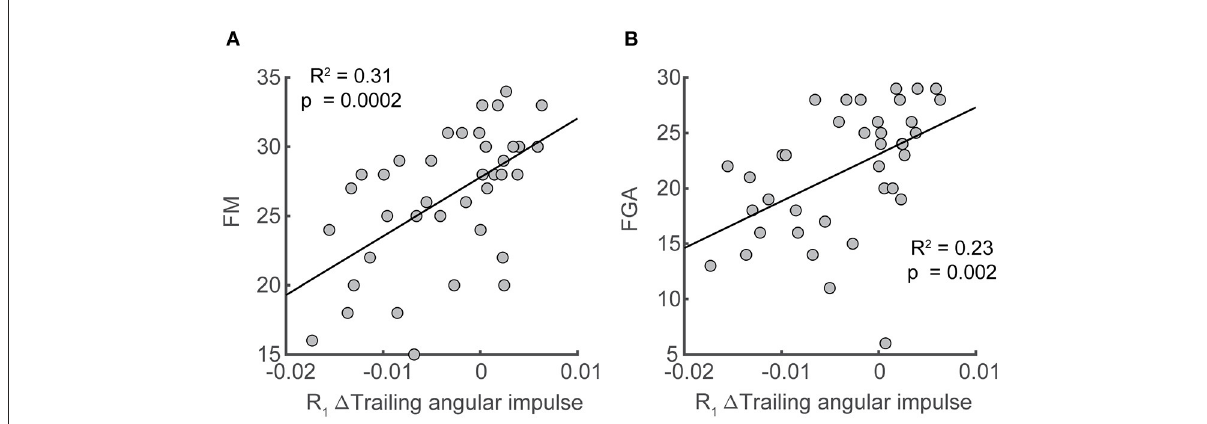
FIGURE8 Associations between deviation in trailing angular impulse during the first recovery step from the pre-perturbation step in the sagittal plane and clinical assessments. Deviation of trailing angular impulse during the first recovery step from the pre-perturbation step was positively associated with (A) Fugl-Meyer score and (B) the Functional Gait Assessment only following paretic perturbations. FM, Fugl-Meyer; FGA, Functional Gait